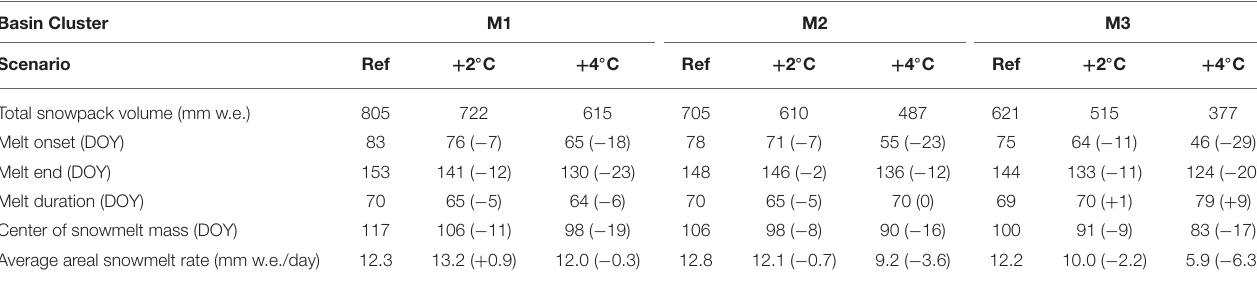
TABLE 1 | Summary of snowpack volume and snowmelt metrics for three basin hypsometries and warming scenarios. Basin Cluster M1